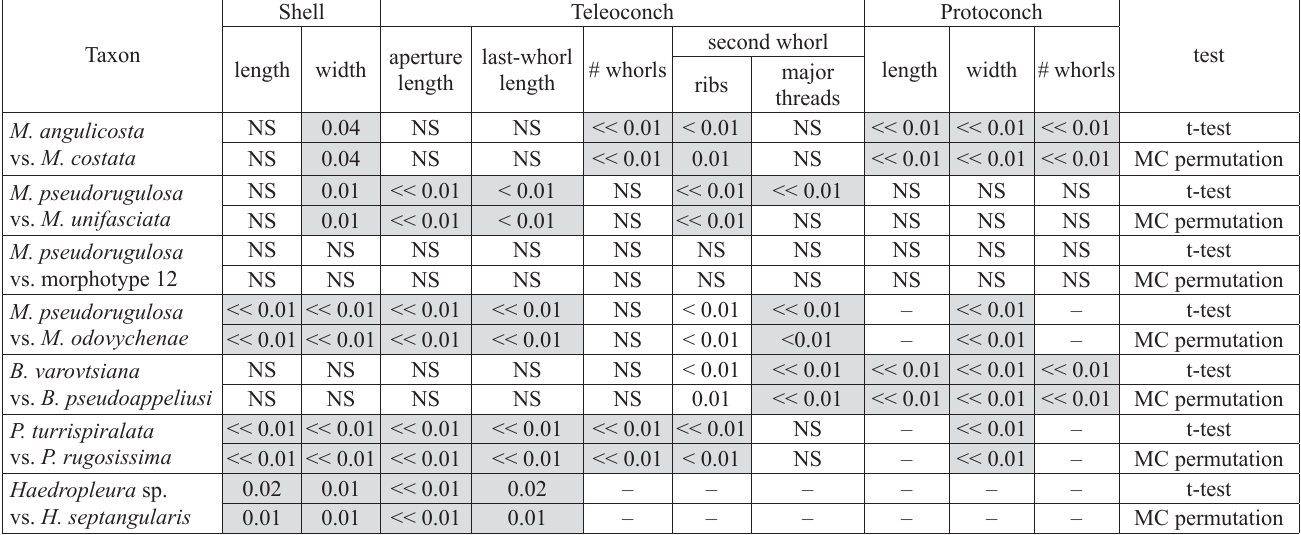
Table 1. Monte Carlo (MC) permutation and t-test results. For each parameter, the sample mean was compared (if n ≥ 10) between allied species via t-test and MC permutation (10 000 iterations), additional tests are reported in SOM 3. Cells report the probability that the two samples come from populations with equal mean; shaded cells, results where the null hypothesis (given the specified alpha level), can be rejected. NS, not significant results; Bonferroni correction applied (further details in SOM 3). Abbreviations: M ., Mangelia ; B ., Bela ; P ., Pyrgocythara ; H ., Haedropleura